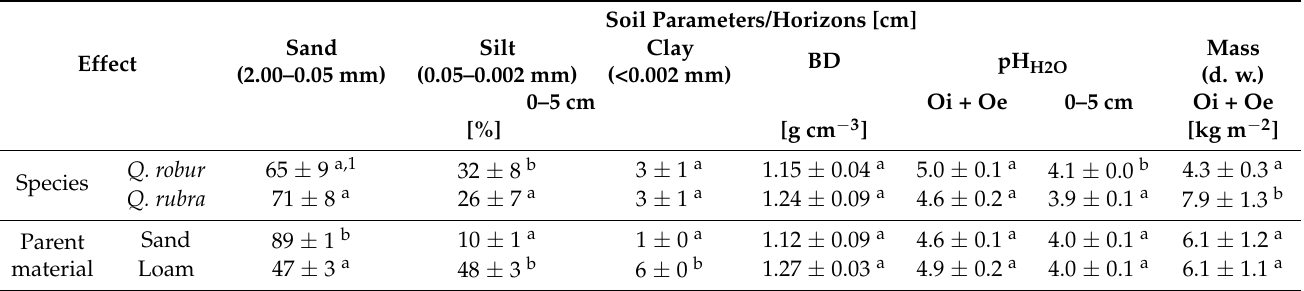
Table 1. Texture, BD, pH H2O and mass of Qi + Oe horizons for post-fire soils under common and red oak stands on reforested post-fire